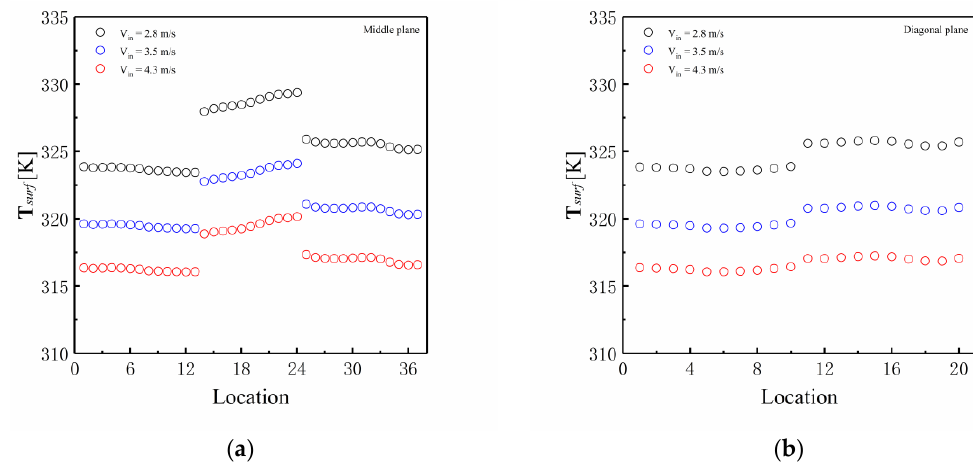
Figure 8. The surface temperature of the pebbles under three other inlet velocities at the ( a ) middle plane and ( b ) the diagonal plane.